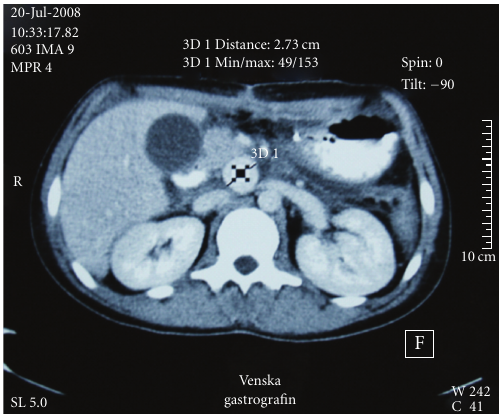
Figure 3: Selective angiography of SMA showing pseudoaneurysm, occlusion of short part of SMA and patent SMA below pseu- doaneurysms, (a) inferior pancreaticoduodenal artery, (b) inferior pancreaticoduodenal artery branches, (c) short neck of artery filling pseudoaneurysm, and (d) distal part of SMA.